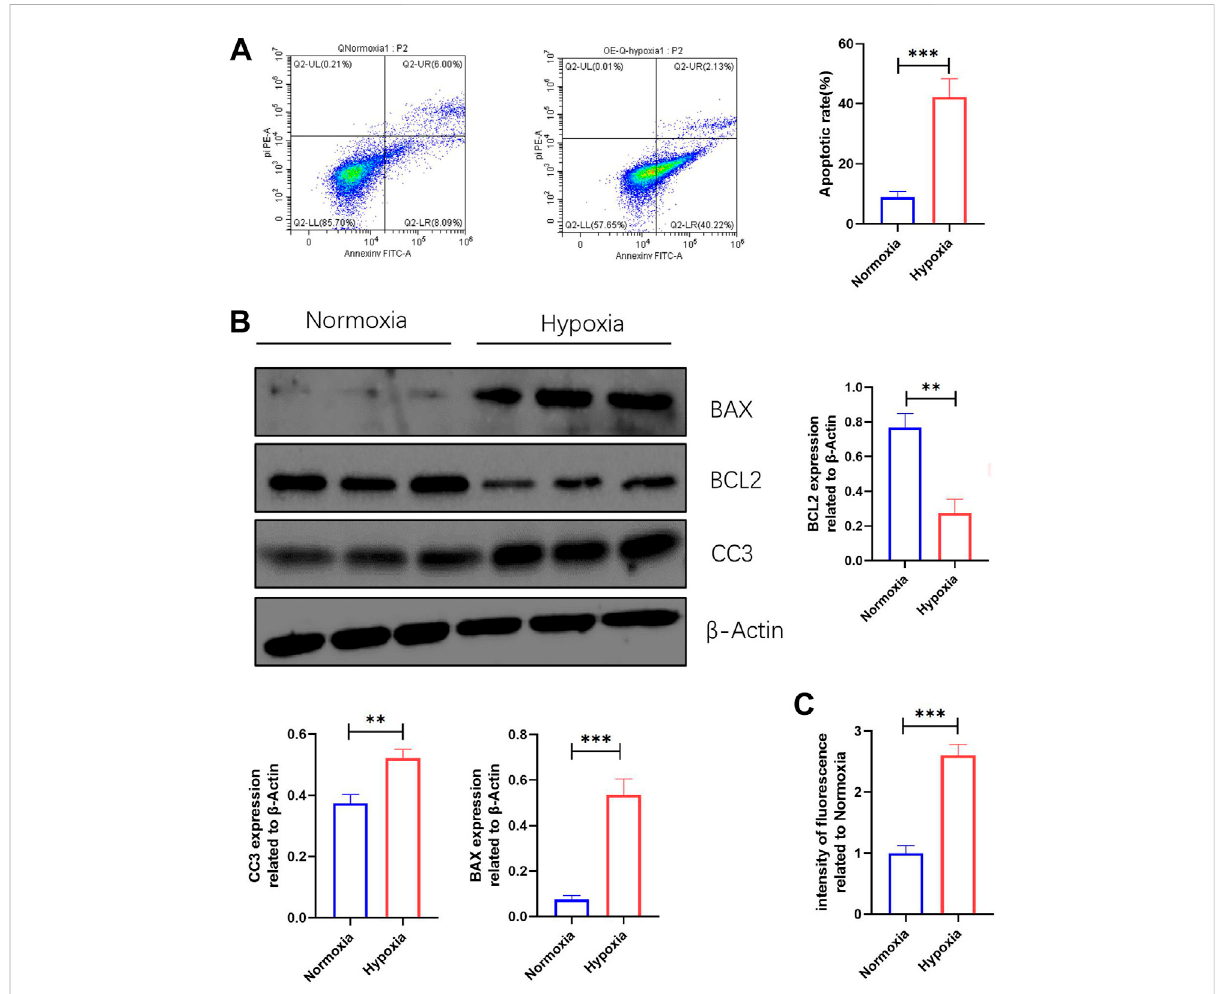
FIGURE 5 ApoptosisandROSproductionareincreasedinNMCMsinresponsetohypoxia. (A) ApoptosisrateinNormoxiaandHypoxiagroups(mean±SD, n =3). (B) WesternblottingshowsproteinintensitiesofBAX2,BCL2,andCC3inNMCMs(mean±SD, n =3). (C) ROS fl uorescenceintensityofNMCMs in Normoxia and Hypoxia groups measured by a microplate reader (mean ± SD, n = 8). **, p < 0.01; ***, p <